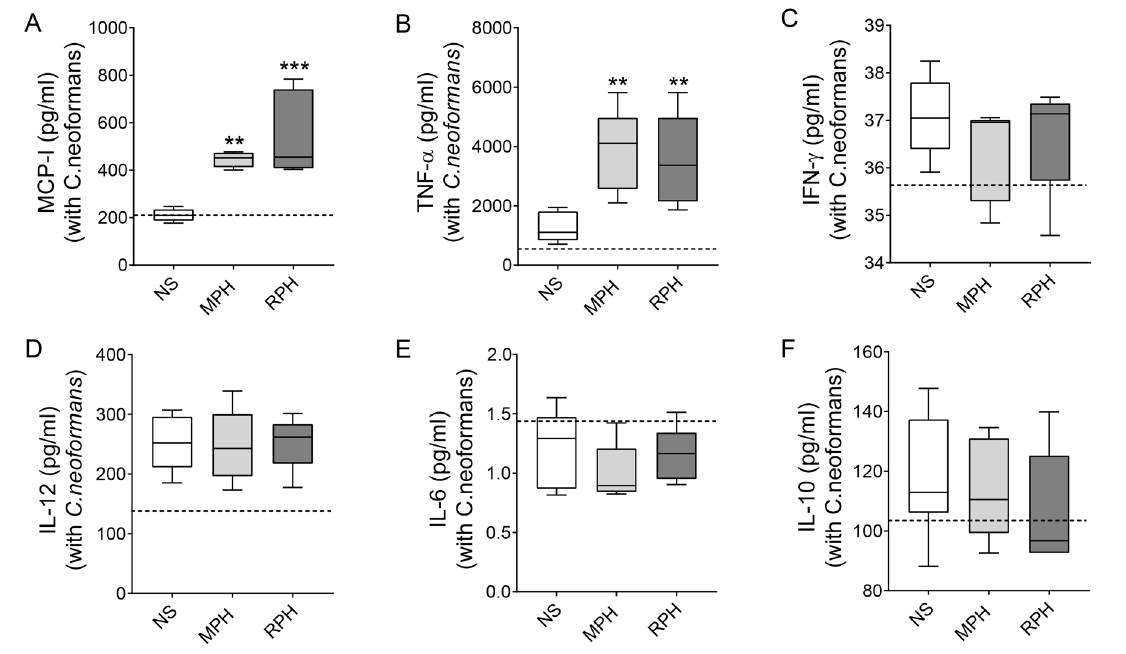
Figure 5. Hemolymph stimuli increase the production of MCP-I/TNF-α in macrophages after 4 hours of incubation. The supernatant of RAW 264.7 cells incubated with C. neoformans was collected after 4 hours of culture, and the production of the following cytokines was analyzed: (A) MCP-I; (B) TNF-α; (C) IFN-γ; (D) IL-12; (E) IL-6 and (F) IL-10. Data representative of one experiment. The significances are relative to the NS group. * p < 0.05; ** p < 0.01; *** p < 0.005.